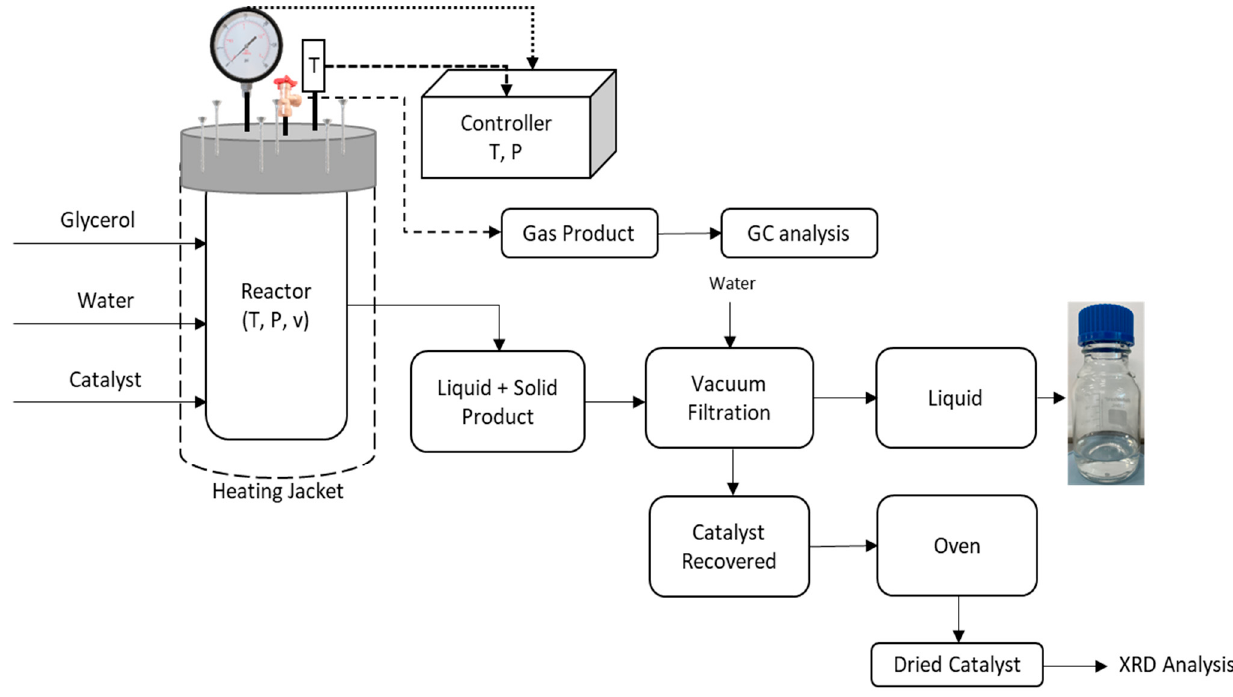
Figure 1. Schematic of the experimental procedure used in this study.